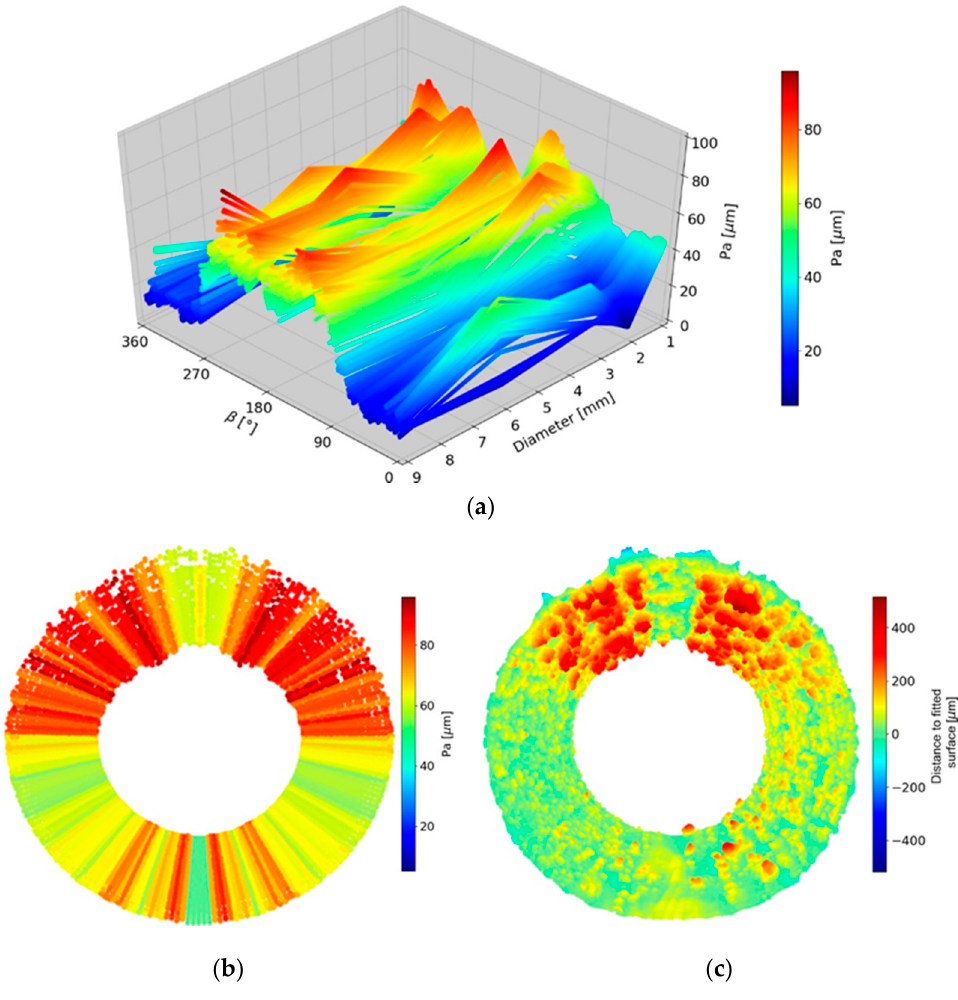
Figure 15. Simple geometry and roughness prediction following the approach of [26]. ( a ) Model Pa ( β , D) with linear interpolation between points along the “Diameter”; ( b ) prediction of 6 mm channel according to the Pa ( β , D) model; ( c ) surface deviation map of 6 mm A.